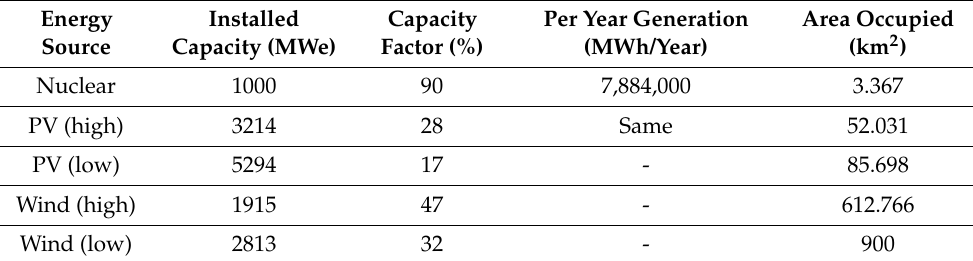
Table 2. Installed capacity against area occupied by nuclear, wind, and solar energy